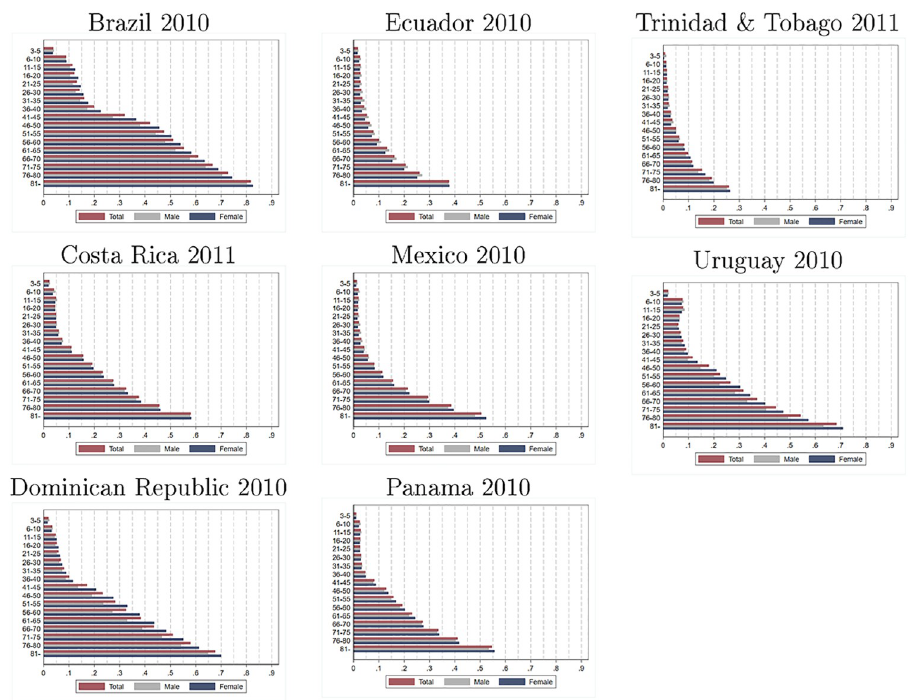
Fig 2. Prevalence of disability: Estimates by age group and sex, by country. Source: authors’ estimations based on data provided by [10] from censuses collected by National Statistics Offices in each country. Estimates for Brazil, Dominican Republic, Ecuador, Mexico, and Panama refer to the year 2010. Estimates for Costa Rica, Trinidad and Tobago, and Uruguay refer to the year 2011. Estimates consider individuals aged 3 and older.